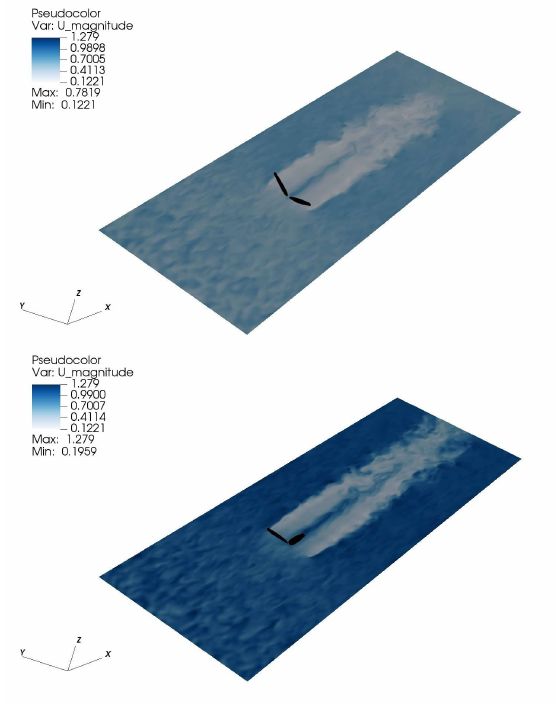
Figure 9. CFD Velocity magnitude for ( top ) Uo = 0.6 m/s and ( bottom ) Uo = 1.0